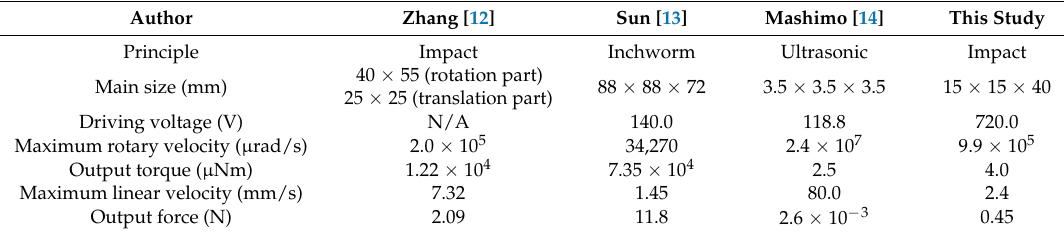
Table 2. Performance comparisons with previous